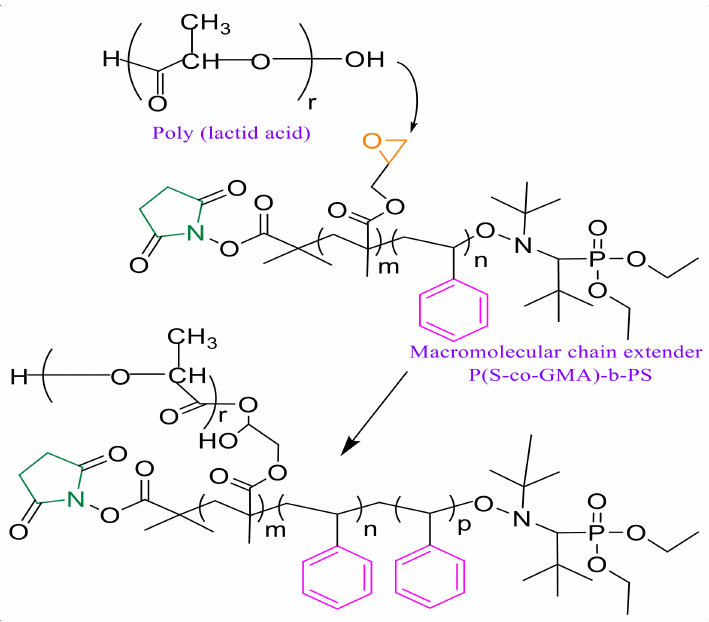
Figure 5. Likely reaction scheme between PLA end groups and P(S-co-GMA)-b-PS epoxy